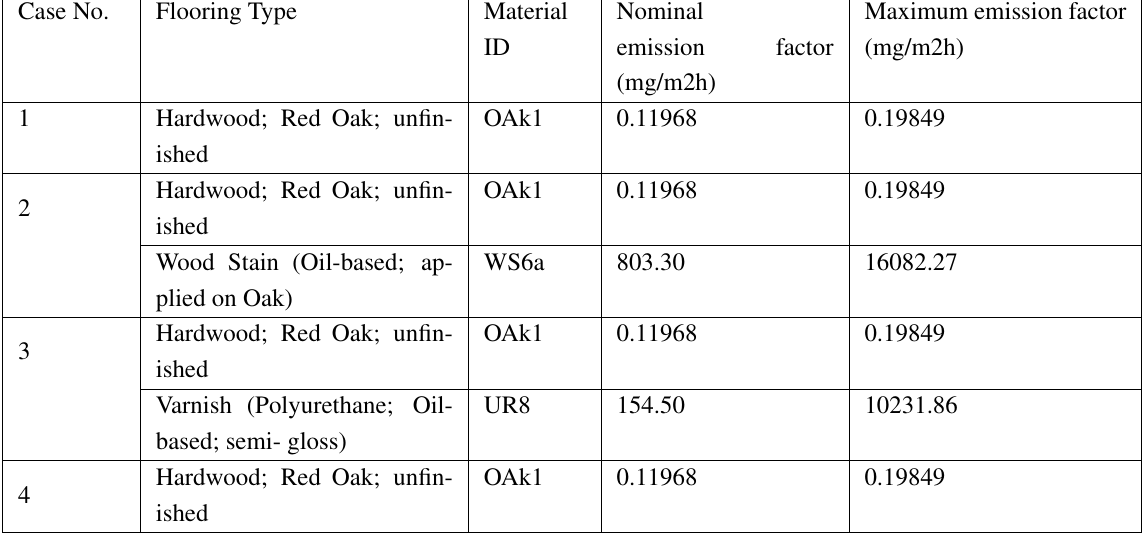
Table 3. The selected materials for cases with emission factor and ID in the NRC database (Won et. al, 2005). Case